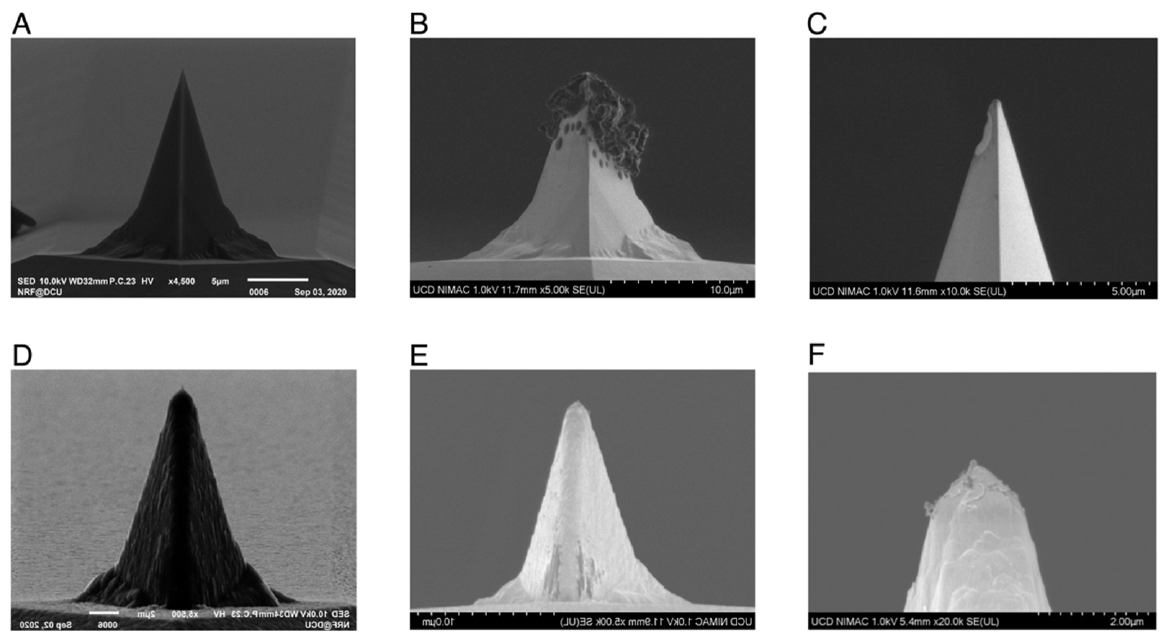
Figure A3. The SEM images of AFM tips. ( A ) Platinum coated tips before experiments ( B ) After experiments with humidity set-up involving the use of NaCl electrolyte ( C ) After experiments in ambient air without any electrolyte ( D ) SEM image of diamond tip before experiment and ( E ) SEM image of diamond tip after experiment in the presence and ( F ) absence of electrolyte. The worn-out tips shown here are imaged after ~12 h of experimentations.